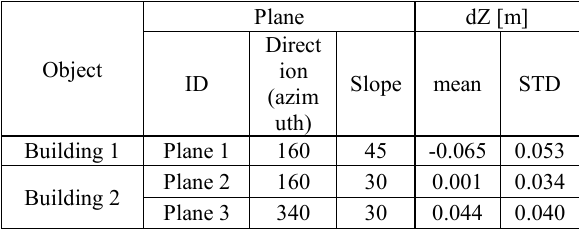
Table 2. The vertical displacement between ULS and TLS data